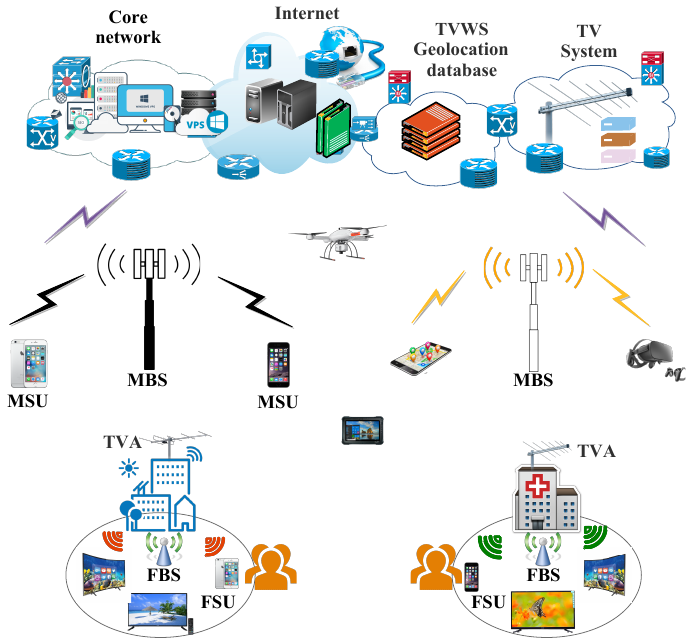
Figure 8. A typical heterogeneous database-assisted TVWS network architecture. TVA: TV Antenna, TVWS: TV white space, MSU: Macro secondary user, Macro base station (MBS), FSU: Femto secondary users, and FBS: Femto base